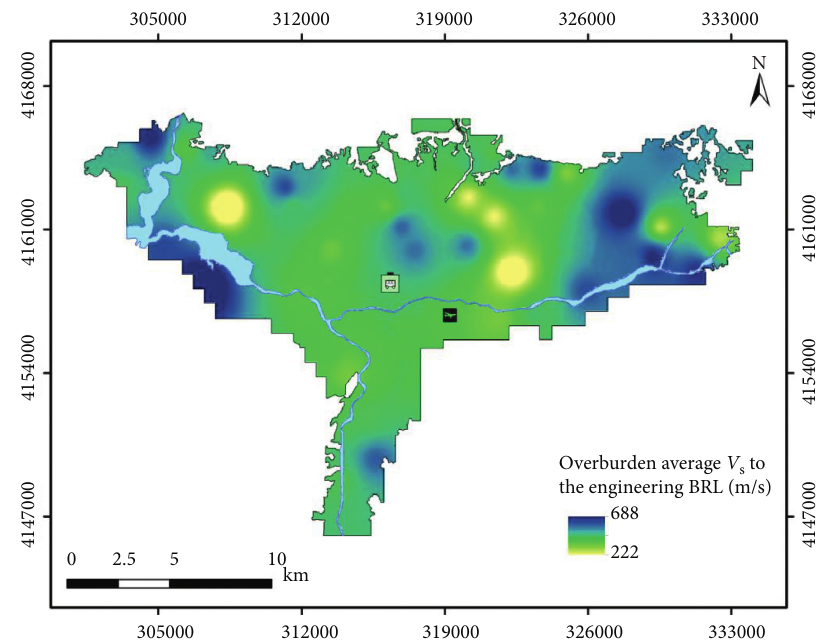
Figure 13: Average V S of overburden soil to the engineering bed rock of Kahramanmaras